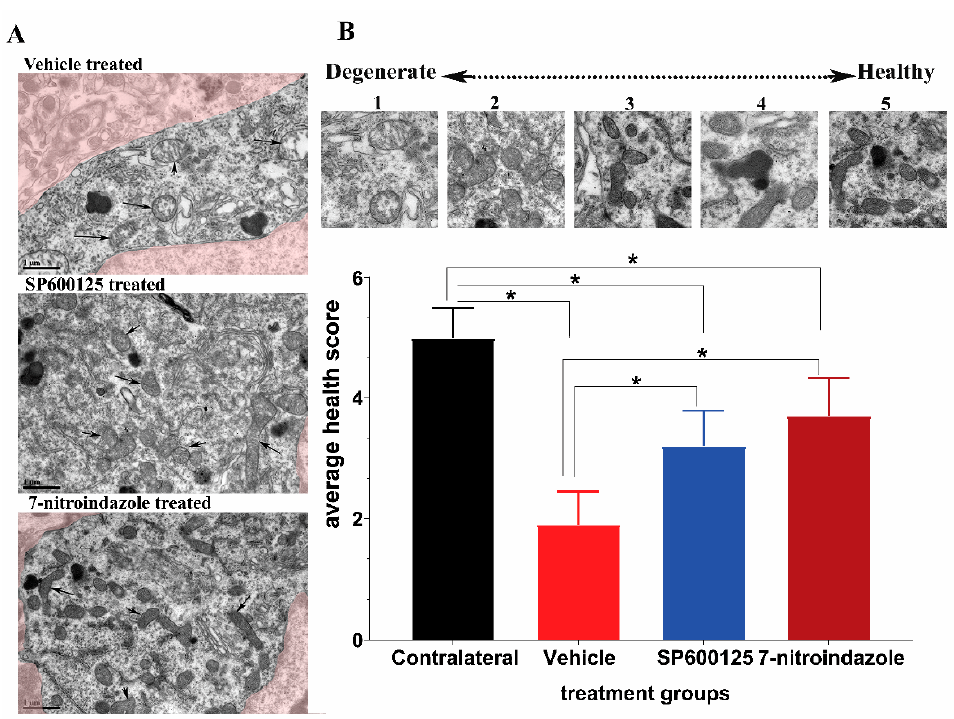
Figure 4. Representative transmission electron microscopy (TEM) images showing mitochondrial morphology. ( A ) shows the mitochondria of motor neurons treated with vehicle, SP600125, and 7-nitroindazole. ( B ) top part shows a health scale of 1 to 5, whereby 5 represents mitochondria of healthiest possible appearance (distinct and well-packed cristae, electron-dense, completely intact inner and outer membranes) while 1 is degenerate. Magnification 13,500 × . Scale bar = 1 µ m. Differences between contralateral side and vehicle or 7-nitroindazole and SP600125-treated rats were significant at * being p < 0.05 using one-way ANOVA followed by Tukey’s